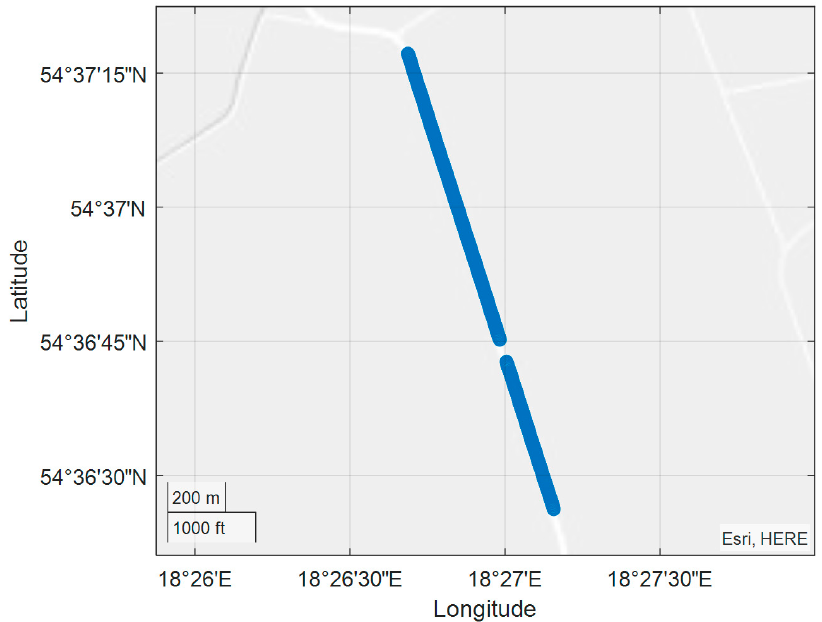
Figure 11. Positions recorded during the road test with the gap in data registration visible on the map view.